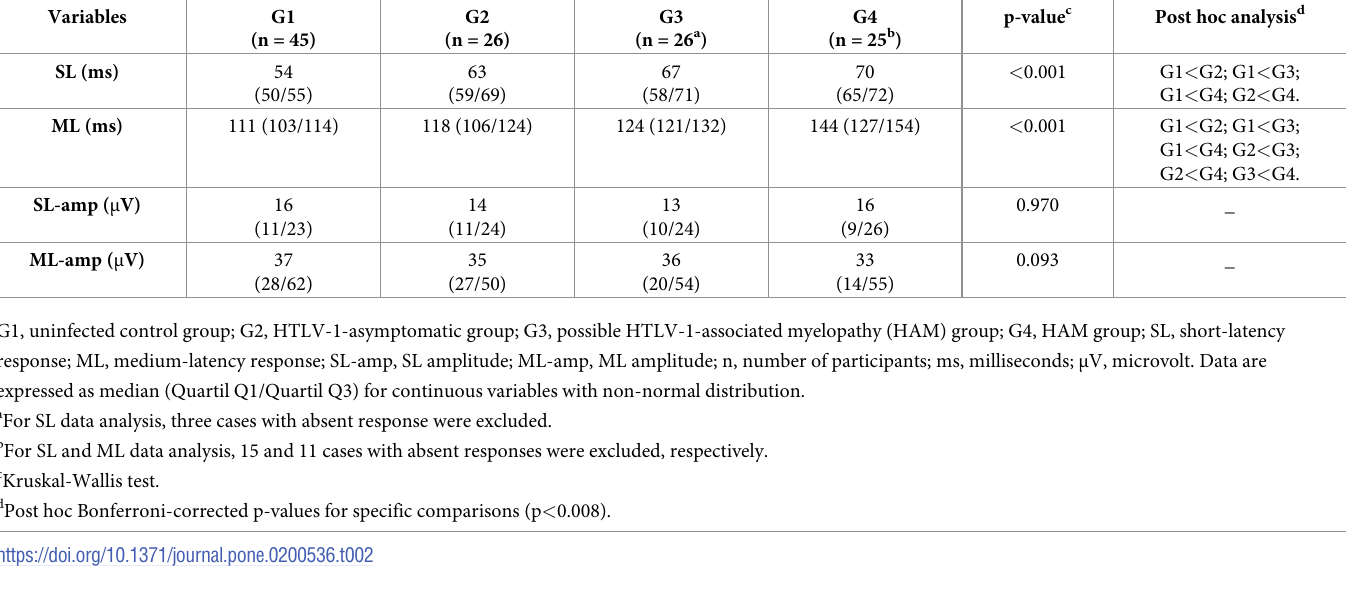
Table 2. Comparative analysis of the latency and amplitude of short-latency (SL) and medium-latency (ML) responses between human T-cell lymphotropic virus type 1 (HTLV-1)-infected and -uninfected groups. Variables